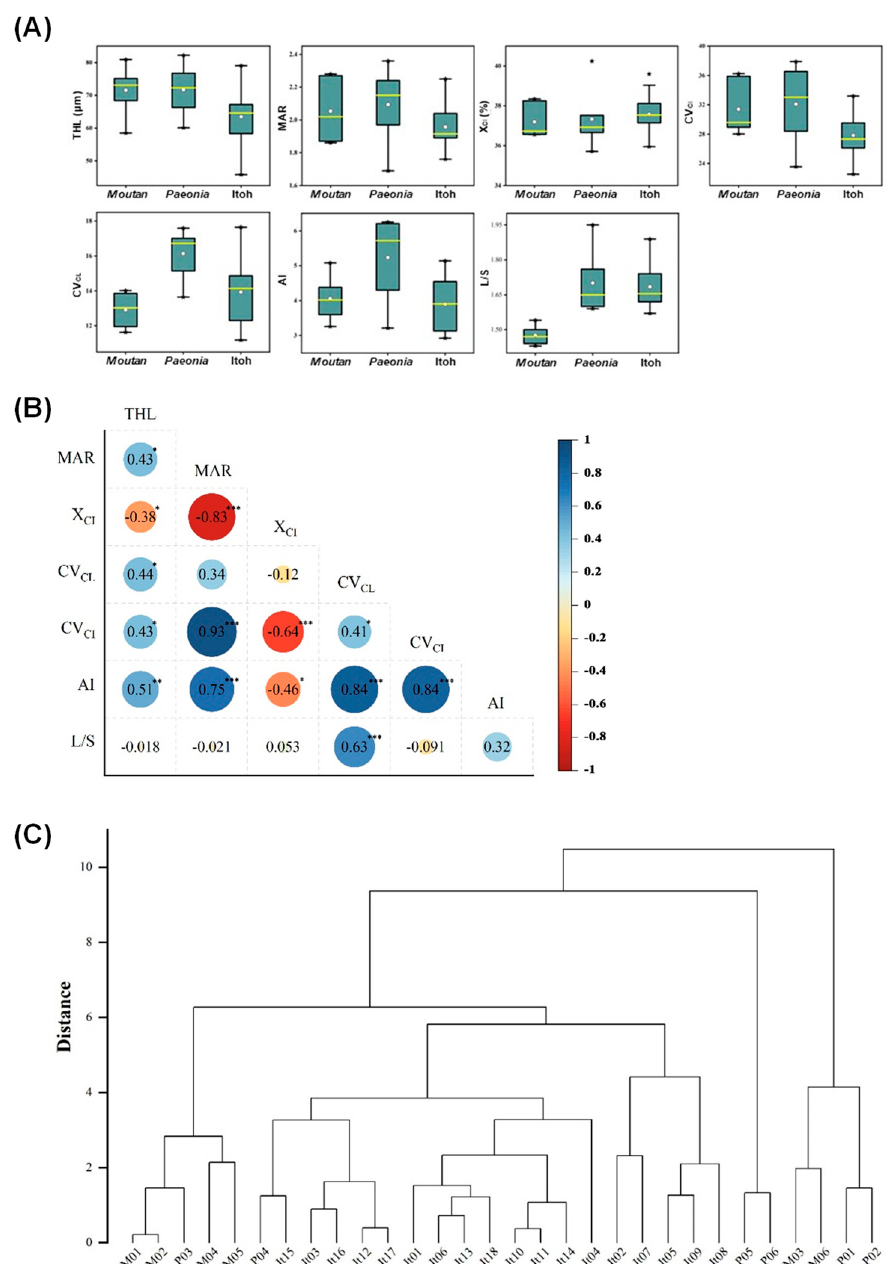
Figure 4. Comparison of karyological diversity among different peony species or varieties in sect. Moutan , sect. Paeonia , and Itoh hybrids. ( A ) The range and distribution of seven chromosomal parameters. Horizontal lines and hollow circles in the box represent median and mean values, respectively [50% of data are within the box, and 99% are within the bar (± SD)]. The asterisks represent data outside the box. ( B ) Pearson correlation analysis of seven chromosomal parameters shown in ( A ); the asterisks *, **, and *** indicate a significant correlation at the 0.05, 0.01, and 0.001 levels, respectively. ( C ) Hierarchical clustering analysis of the 30 peonies based on the seven chromosomal parameters shown in ( A ). The names of 30 peonies and categories of seven parameters are shown in Tables 1 and 2.